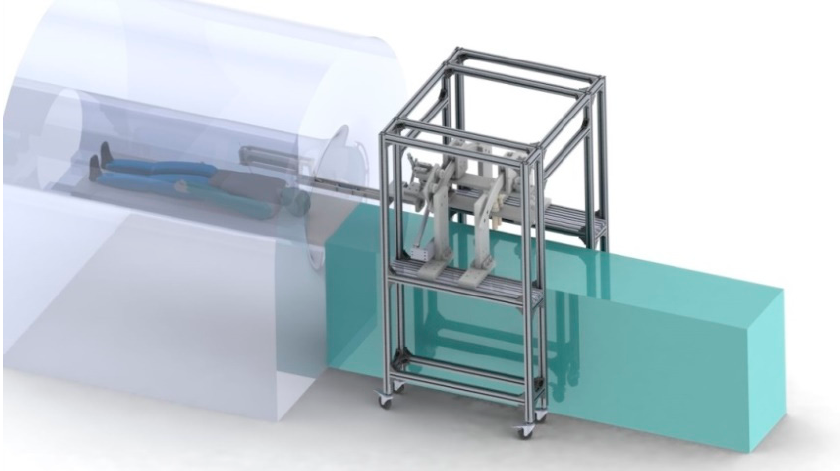
Figure 1. Virtual prototype of a 5-DOF (degree of freedom) magnetic resonance imaging (MRI) compatible robot for abdominal and thoracic punctures.